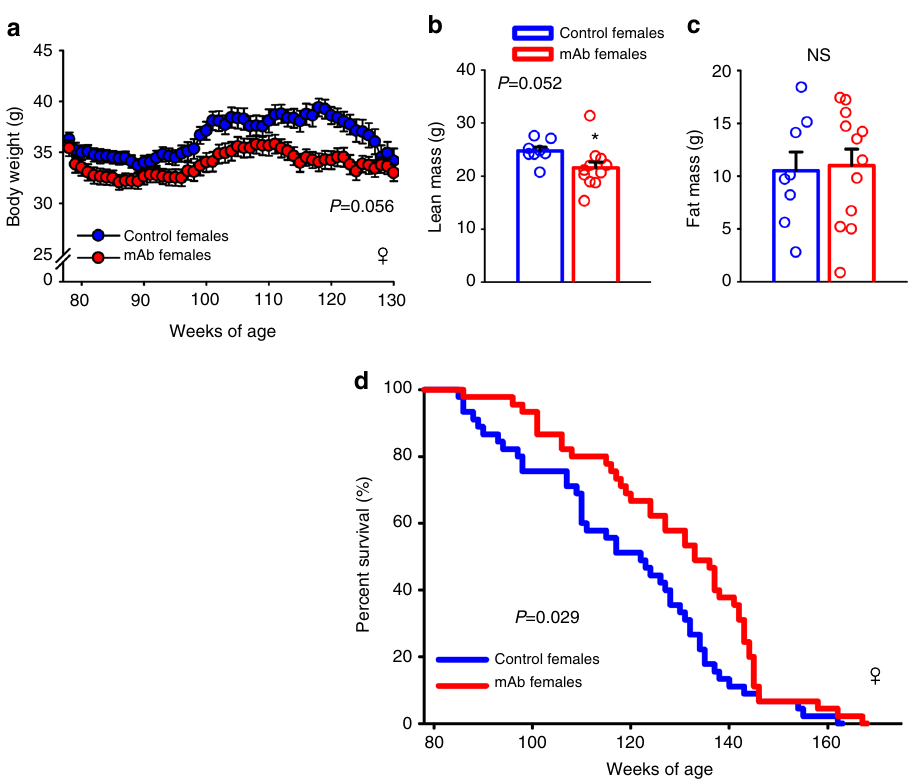
Fig. 6 Late-life IGF-1R modulation improves female lifespan. a Chronic mAb treatment beginning at 78 wks of age (~18 mo) in CB6F1 female mice tended to cause a slight and persistent reduction in body weight (group effect , P = 0.056). b , c This reduction in body weight was attributed to a reduction in lean mass ( P = 0.052), rather than adiposity, as assessed by qMR. d Importantly, late-life mAb treatment was able to signi fi cantly improve mean ( P = 0.023) and median lifespan ( P = 0.03), as well as survival after 78 weeks of age (HR = 0.622, P = 0.029; n = 45 per group), but did not improve maximum lifespan. Details regarding these analyses and related R code can be found in the Statistics section and here: [https://doi.org/10.17605/OSF.IO/8QGX9. Bars are means ± s.e.m. Dot plots overlaid on bar graphs represent individual data points. NS not signi fi cant. *Signi fi cantly different from Controls by independent samples t-test , P =